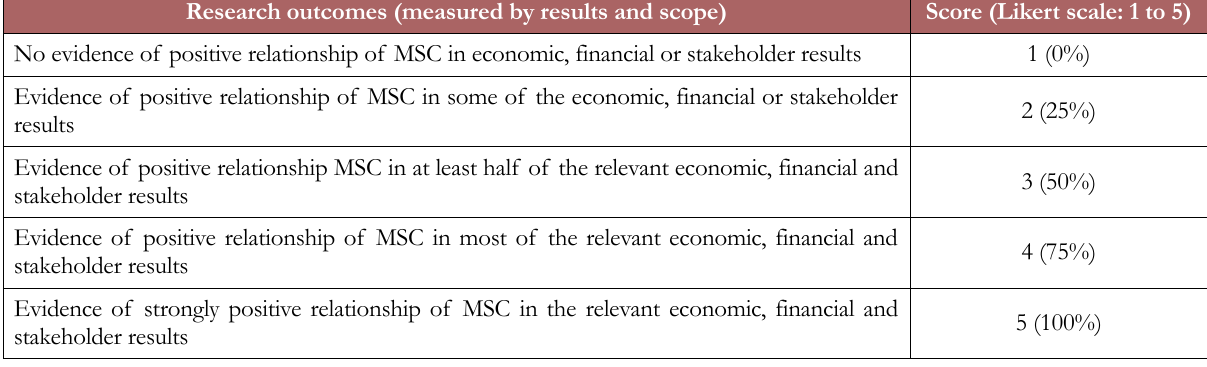
Table 1. Evaluation scale to access benefits of